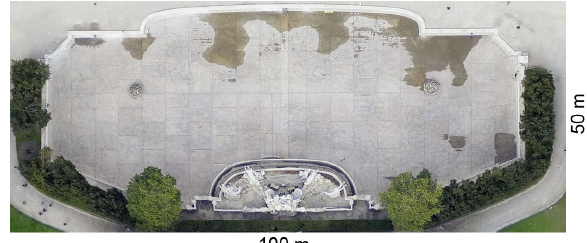
Figure 1. Ortho-image of the Neptune Fountain showing the main basin, the cascade basins, and the 5 sculpture ensembles.